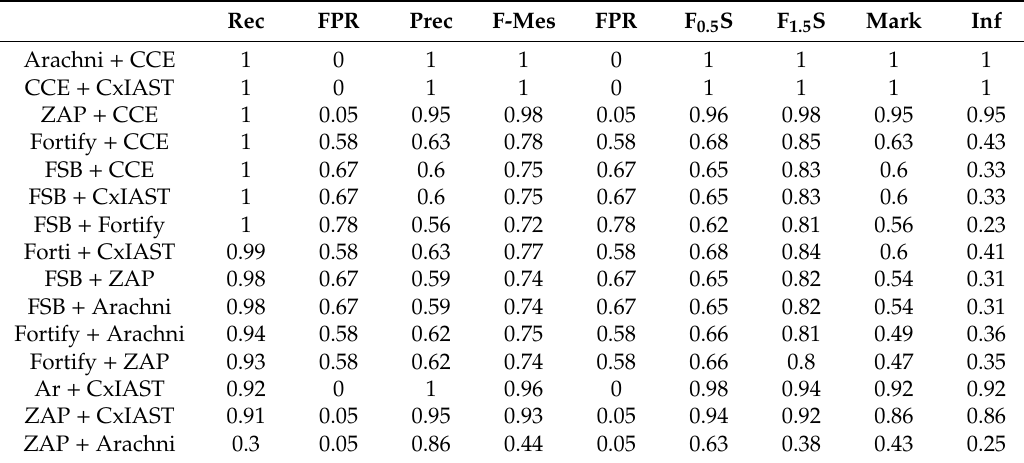
Table 6. Application of the metrics to 2-tools combinations.